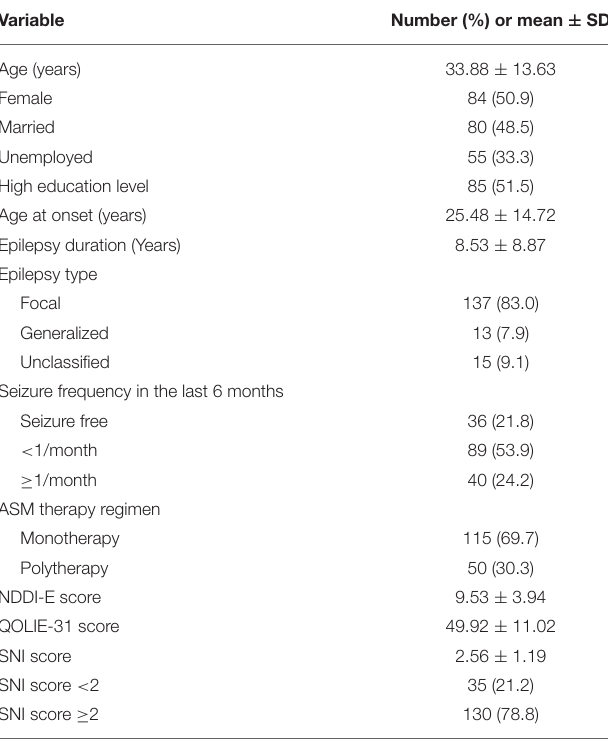
TABLE 1 | Demographic and clinical characteristics of total participants ( N = 165). TABLE 2 | Comparison of demographic and clinical characteristics in socially isolated group and socially connected group.